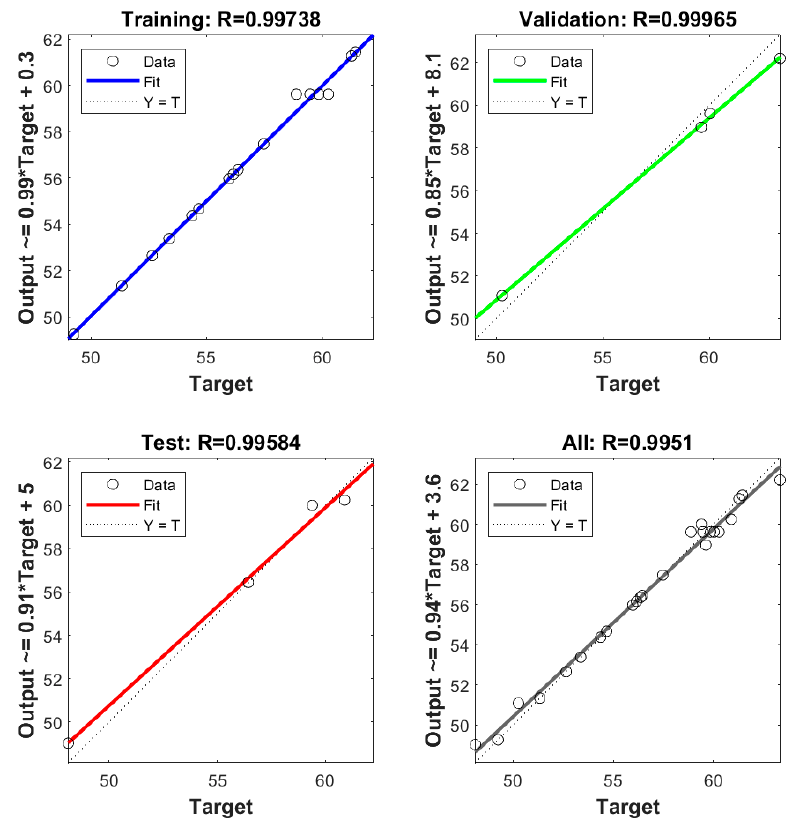
Figure 10. Regression plot of experimental data and BP-ANN model simulated values.